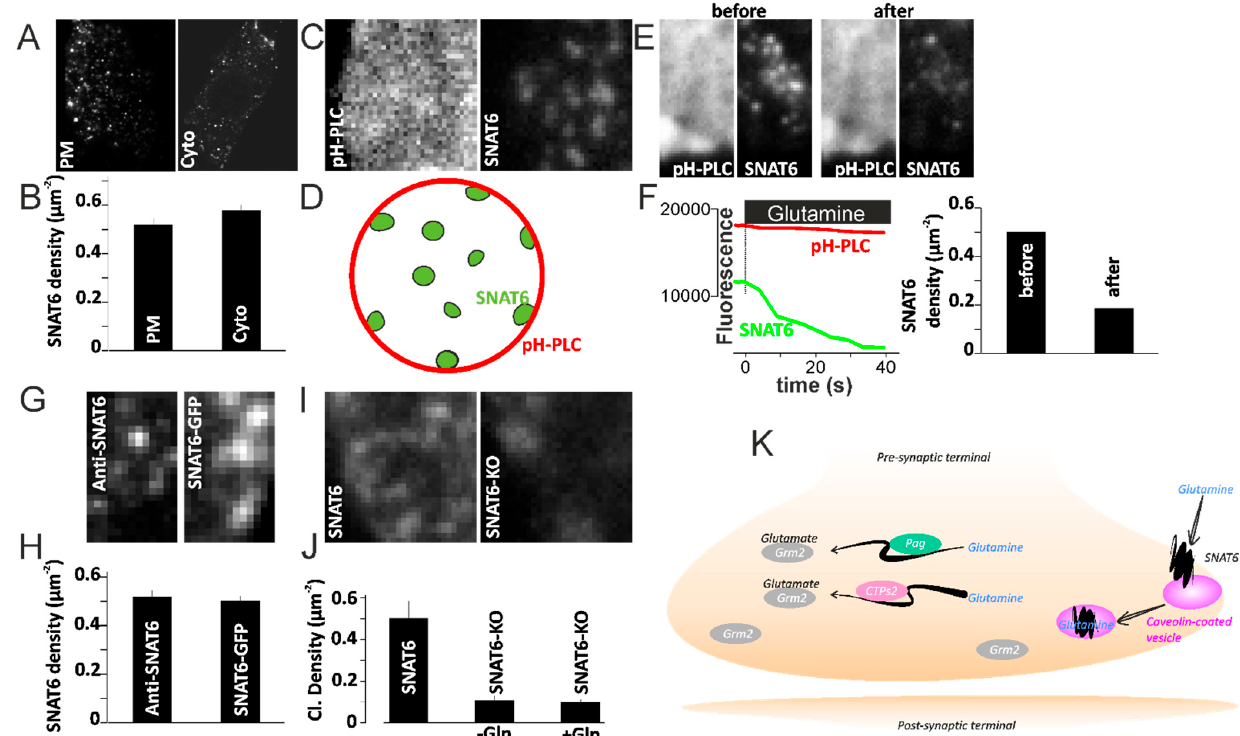
Figure 6. SNAT6 downstream signalling. ( A ) Immunostained images of SNAT6 at the plasma membrane (PM) and cytosol (cyto) of the cell. ( B ) Density of SNAT6 clusters was assessed using plugin called “find maxima” described in the methods. ( C ) Cells co-transfected using PtdIns(4,5)P 2 labeled with PH domains of PLC δ 1-mRFP (pH-PLC) and SNAT6 labeled with GFP images obtained using TIRF microscopy. ( D ) Cartoon showing SNAT6 distribution in the cell and PIP 2 at the plasma membrane. ( E ) Images as in C for cells before stimulating with glutamine and after stimulating with glutamine. ( F ) Trace showing fluorescence of the entire single cell for SNAT6 (green) and PIP 2 marker pH-PLC (red). Note that the stimulation with glutamine was initiated at time zero. The density of SNAT6 clusters before and after stimulation is shown on the right. ( G ) Images showing SNAT6 immunostained using a specific antibody and SNAT6 tagged to GFP. ( H ) Density of SNAT6 from the images similar to displayed in E analyzed using “find maxima” as described in the methods. ( I ) Images from SNAT6 immunolabeled cells fixed after siRNA mediated knockdown of SNAT6 or untransfected control cells. ( J ) Density of immunostained SNAT6 from the untrasfected cells or cells undergone siRNA mediated knockdown of SNAT6 fixed with or without prior Gln stimulation analyzed using “find maxima” as described in the methods. Note SNAT6-KO cells have significantly fewer clusters ( p < 0.001). All experiments were repeated two or three times independently and each bar graphs represents 12–50 cells each. ( K ) A proposed model illustrating how SNAT6 might be regulating the glutamate–glutamine cycle: SNAT6 transports in glutamine from astrocytes to the pre-synaptic terminal of excitatory neurons. SNAT6–caveolin complexes internalize upon binding to glutamine. Two enzymes Pag and CTPs2 then convert the glutamine to glutamate via two separate pathways. The glutamate produced then binds to the glutamate-receptor Grm2 prior to its release.